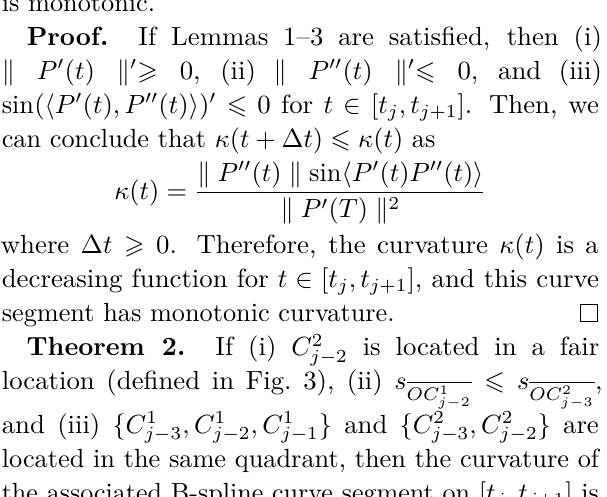
Fig. 4 A special case of Theorem 2.